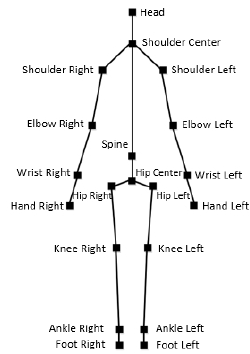
Figure 4. Depiction of human skeleton in Kinect 2.0 ( Source: